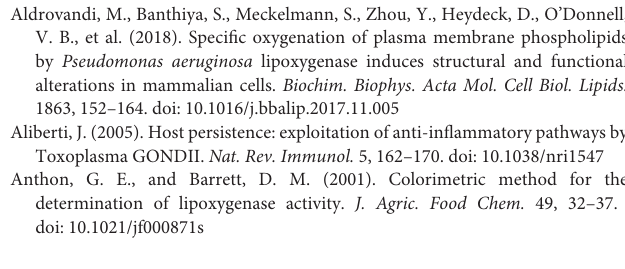
TABLE S4 | Concentration of metabolites (pg/mg of protein) in BALF from LPS (3 µ g/mouse) treated mice co-challenged or not either with heat-inactivated or